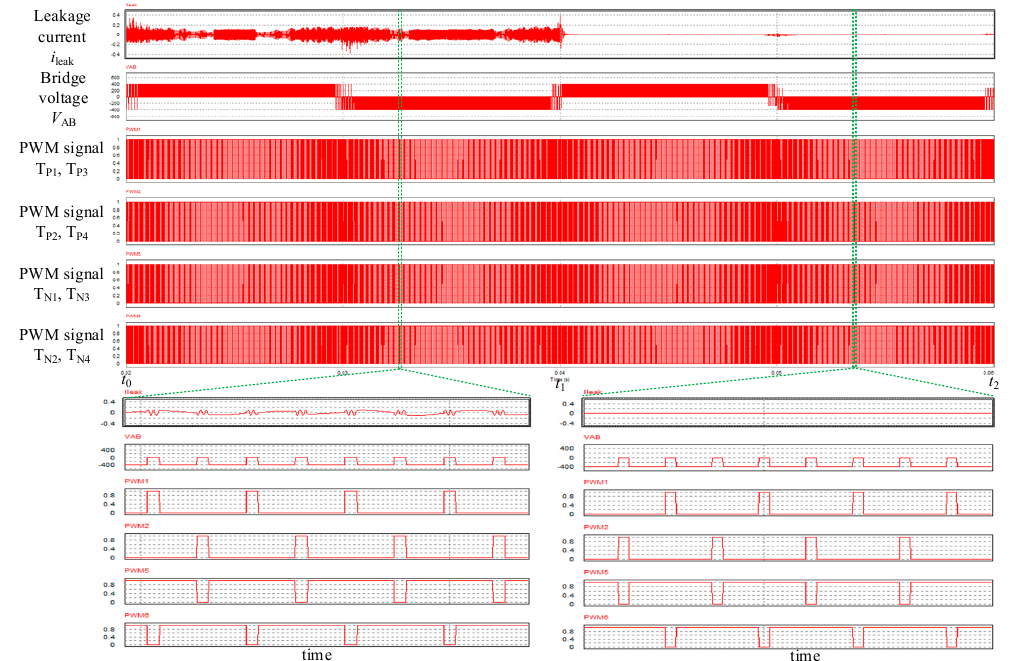
Figure 33. Waveforms of leakage current, voltage V AB , and PWM signal.